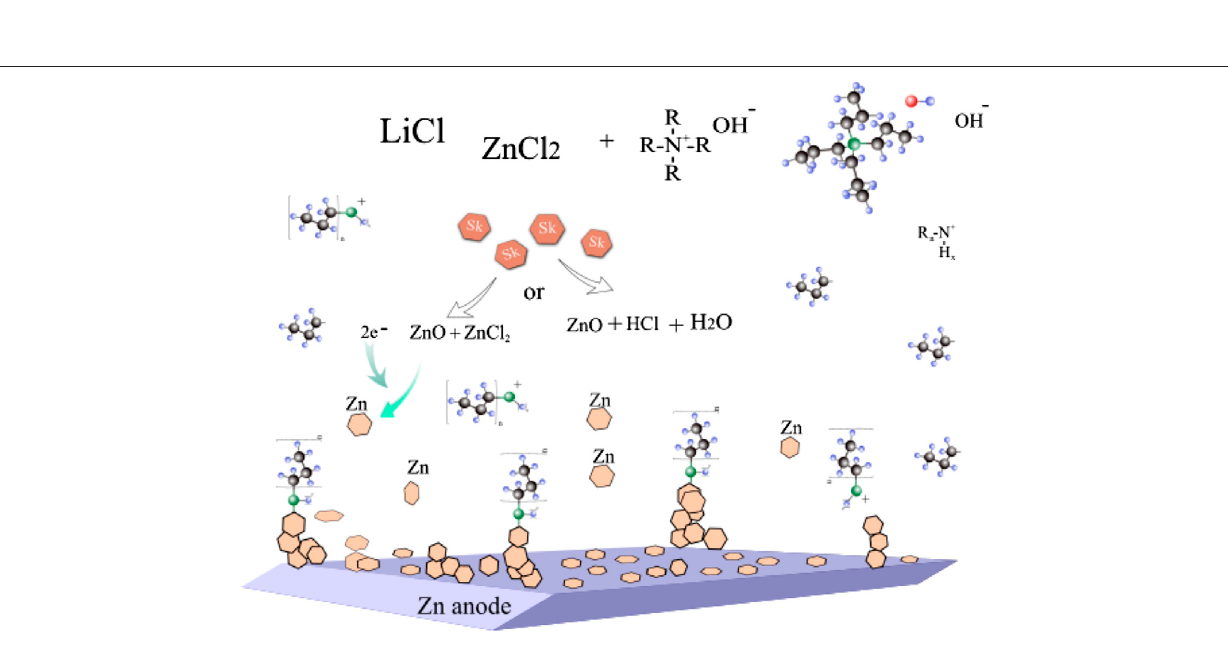
Frontiers in Energy Research |